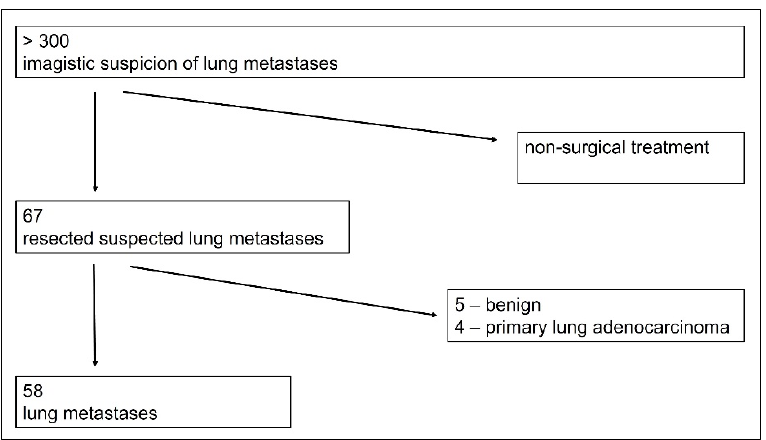
Figure 1. Inclusion criteria for patients in the study—selection from the presenting patients with suspicioned lung metastases.